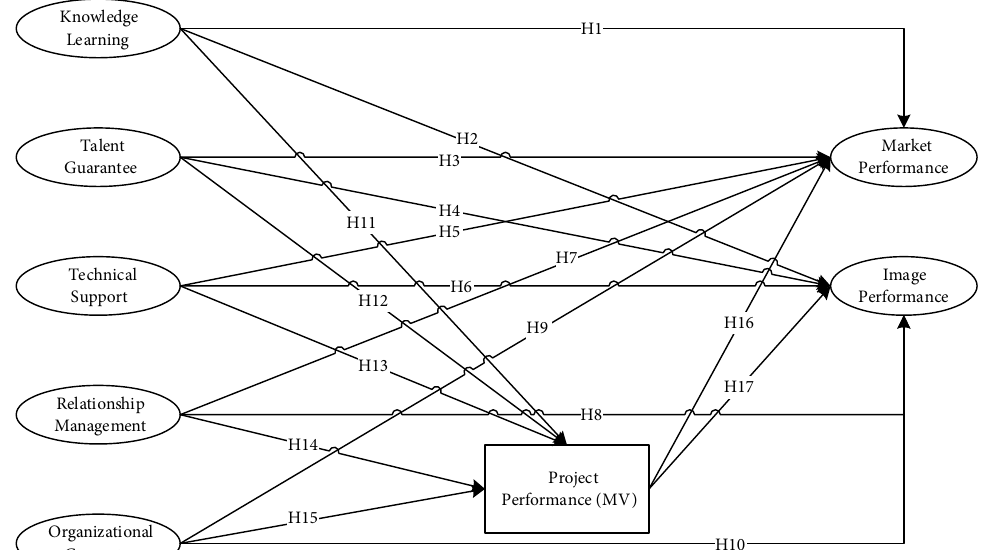
Figure 1. Initial theoretical